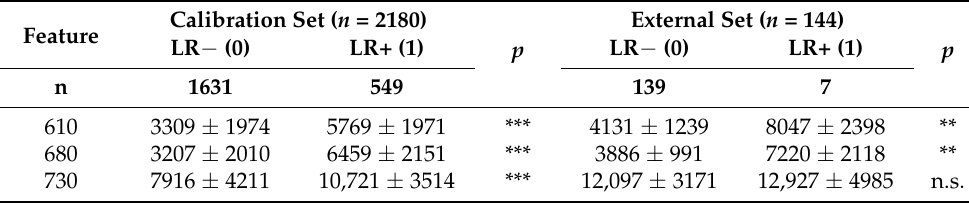
Figure 3. Principal component analysis of the multispectral sensor reads and the corresponding normalized difference vegetation indexes. ( a ) shows principal components 1 and 2, and principal components 1 and 3 are shown in ( b ). Arrows represent eigenvectors of the variables (Table S1) and ellipses represent 95% confidence intervals for each group based on Gaussian distribution. Table 2. Raw sensor output at six wavelengths and 15 values of normalized difference vegetation indexes (VI) calculated from unique combinations of six wavelengths expressed as a mean ± standard deviation for maize plots showing leaf rolling (LR+) and no leaf rolling (LR − ) in calibration ( n = 2180) and external ( n = 144) datasets measured by a multispectral sensor. Column p denotes significance according to two-sample t -test at values of α < 0.05 (*), <0.01 (**) and <0.001 (***). p values of differences >0.05 are denoted as non-significant